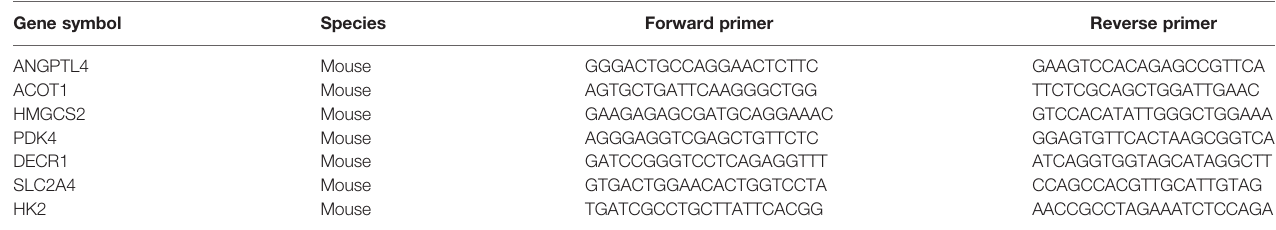
TABLE 1 | Primers of genes determined by quantitative real-time polymerase chain